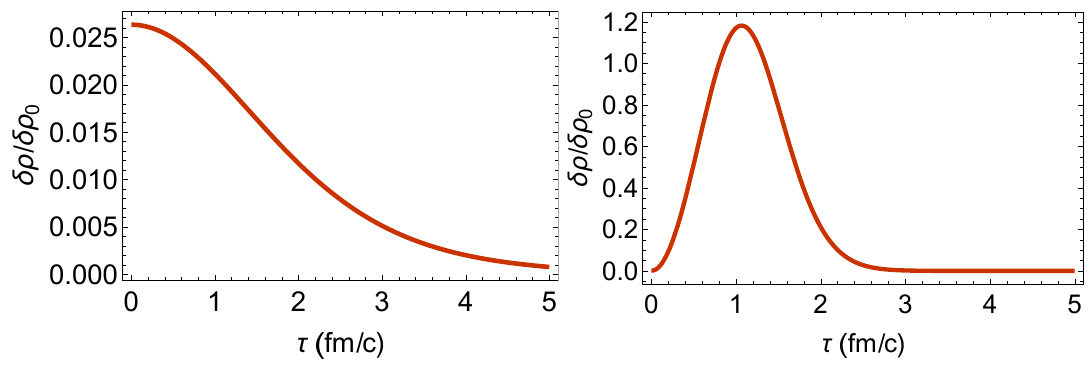
Figure 11 . (color online). Temporal evolution of (cid:14)(cid:26) e with respect to (cid:14)(cid:26) e; 0 de(cid:12)ned in (6.8) at (a) y = x ? , and (b) y = L . Other parameters are 0